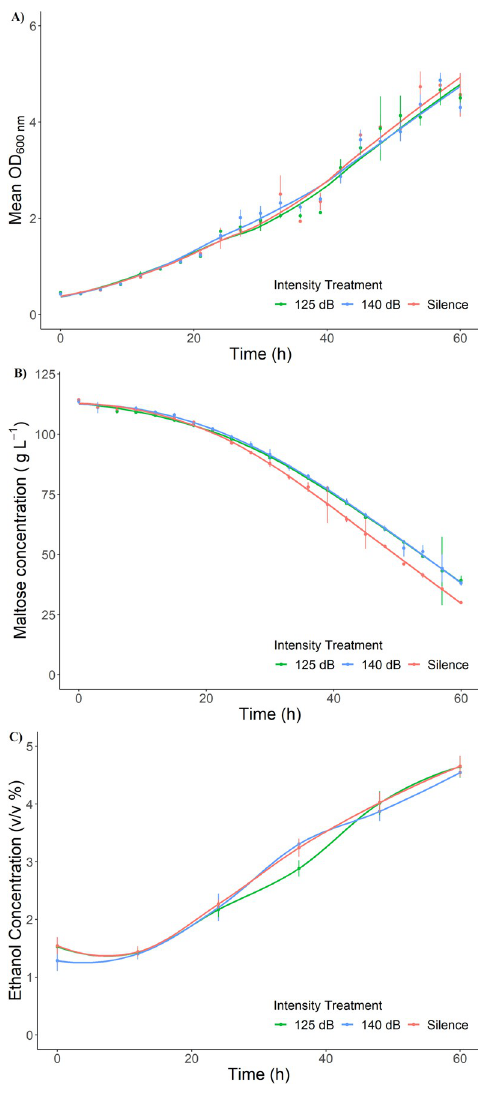
Fig 5. Effect of sound intensity on fermentation performance of S . cerevisiae in minimal medium. Plots show yeast growth (A), maltose consumption (B), and ethanol production (C) over 60 h for two sound intensities at 0.8–2 kHz, as well as silence. Mean values (dots) and standard deviation (error bars) for three biological replicates are shown. See S1 Table for data used.